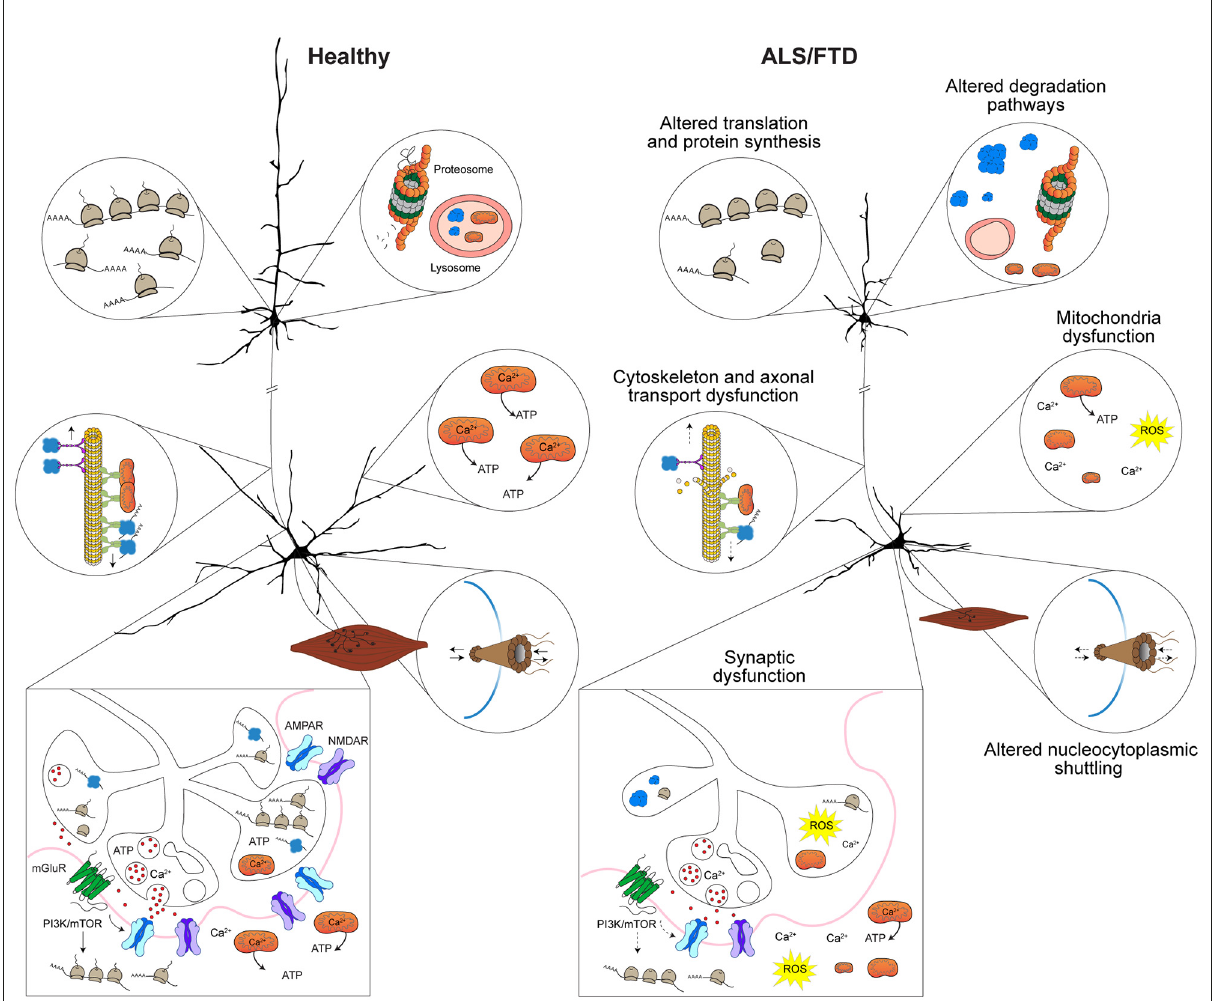
FIGURE2 Mechanisms implicated in synaptic dysfunction in ALS and FTD. Altered proteostasis in ALS and FTD caused by misregulation of translation and protein synthesis affects several cellular processes including those implicated in neuronal morphology and synaptic homeostasis. Protein degradation pathways that involve the lysosome, autophagy, mitophagy, and the proteosome are dysfunctional in ALS and FTD result in toxic proteinaccumulationandleadtodefectsinneuronalfunctionandsynapticcommunication.Cytoskeletaldisruptionordisarrangementthatoccur in ALS and FTD lead to structural instability of dendrites, axons and synapses and affect axonal transport of RNA granules, ribosomal subunits and organelles (i.e., mitochondria) to dendrites and synapse. In ALS and FTD, altered nucleocytoplasmic trafficking of proteins and altered physical properties of proteins (i.e., stress granule dynamics or liquid-liquid phase transitions) affect protein interactions and impact mRNA transport and local translation in axons, dendrites and synapses. Depletion or defective mitochondria within dendrites and at synapses that is observed in ALS and FTD affects Ca 2+ levels and reduce ATP levels, which affects several processes including synaptic vesicle cycling and release, synaptic transmission, and local protein synthesis. Depicted upper and lower motor neurons were modified with permission from Sephton et al.